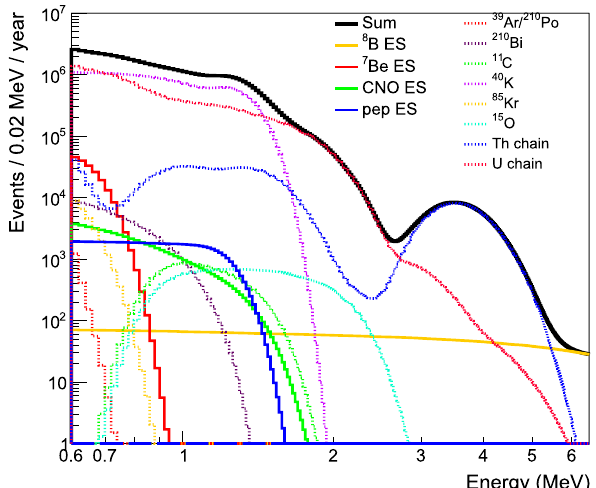
Fig. 8 Energyspectrumofexpectedsignalsfora25kiloton,5%WbLS loaded detector